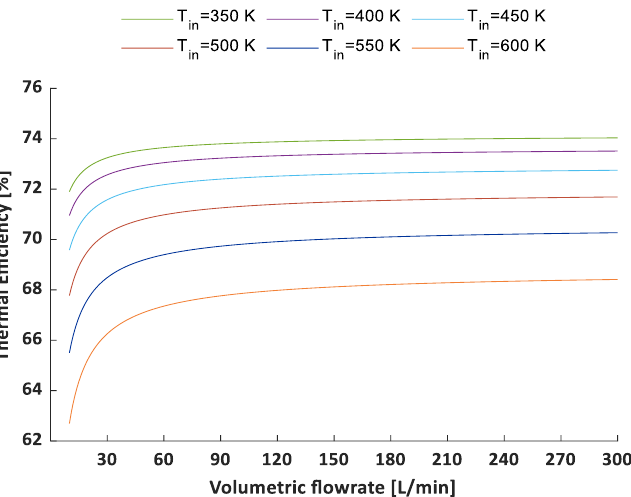
Figure 3. Effect of change in flow rate and inlet temperature on thermal efficiency.